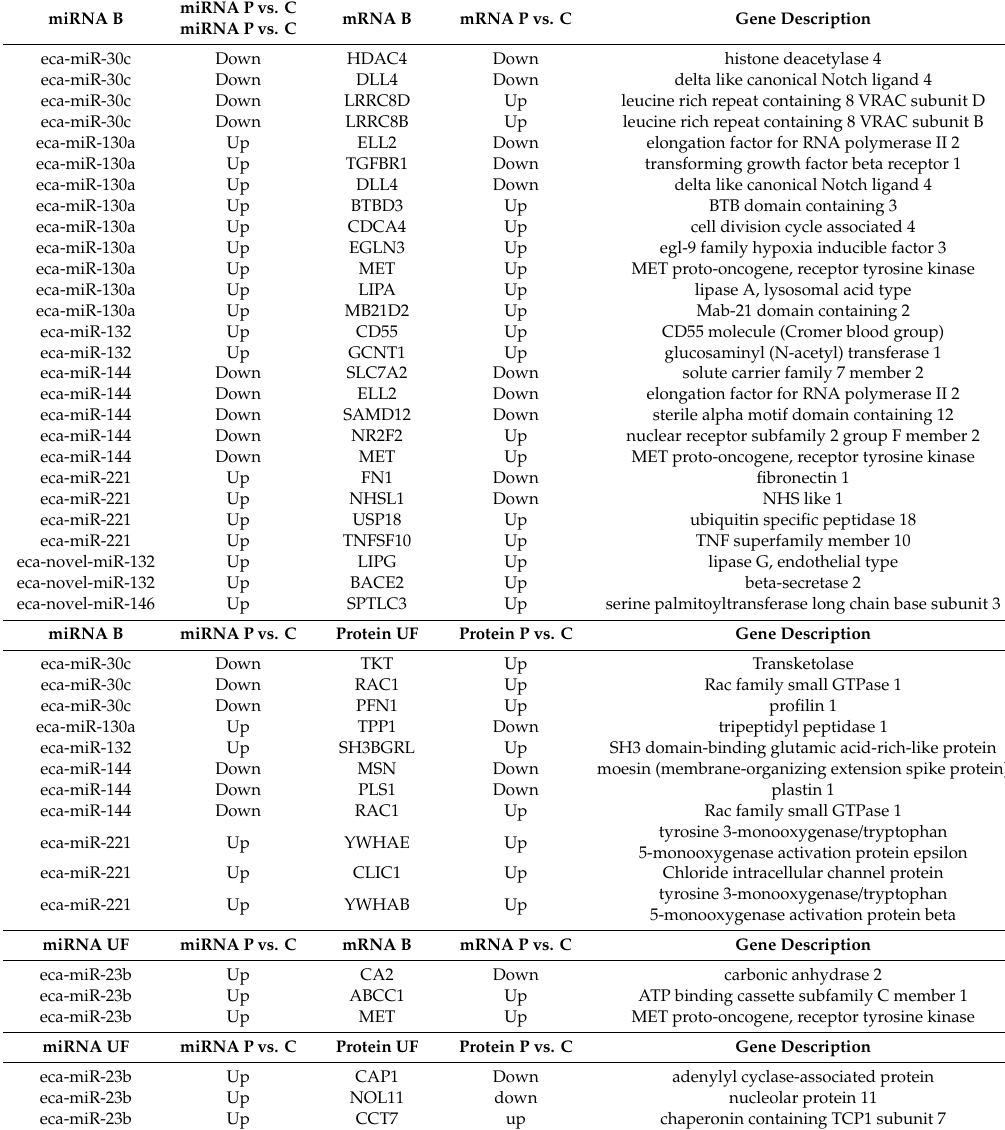
Table 1. Targets of di ff erentially expressed miRNAs in the endometrial biopsies (B) and uterine fluid (UF) of pregnant (P) versus cyclic (C) mares on day 13 after ovulation. Targets of di ff erentially expressed miRNAs validated in miRTarBase were compared with di ff erentially expressed mRNAs and proteins in the same